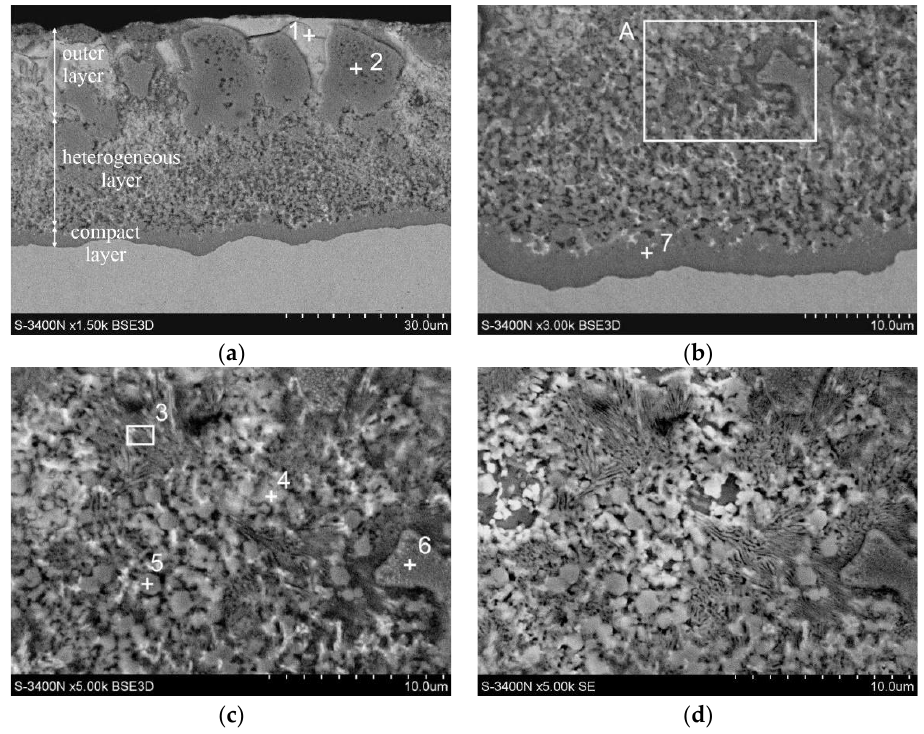
Figure 4. SEM microstructure of the coating obtained in the bath ZnAl23Mg6Si0.2: ( a ) coating cross-section, ( b ) diffusion layer ( c ) micro-area A — backscattered electron (BSE) image, ( d ) micro-area A — secondary electron (SE) image. Table 5. Chemical composition in the micro-areas (EDS) of the coating obtained in the ZnAl23Mg6Si0.2 bath (analysis points as shown in Figure 4).